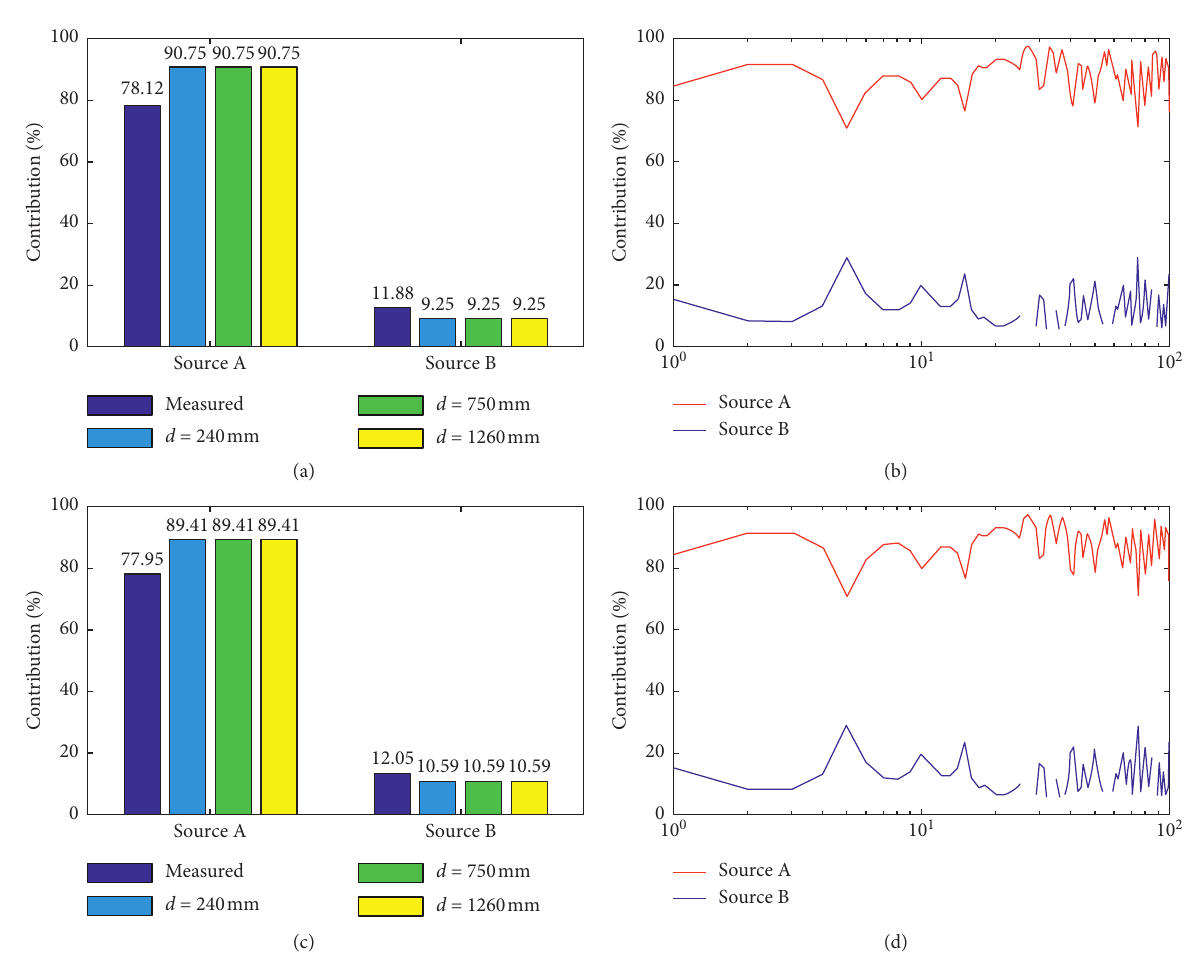
Figure 28: Contributions of each source for 3 different receiver distances: (a) contribution per source, measurement #1; (b) contribution point by point, measurement #1; (c) contribution per source, measurement #2; (d) contribution point by point, measurement #2.